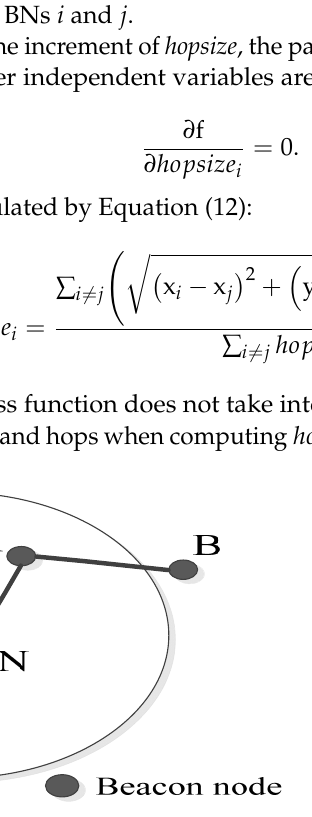
Figure 3. Distribution diagram of beacon nodes.